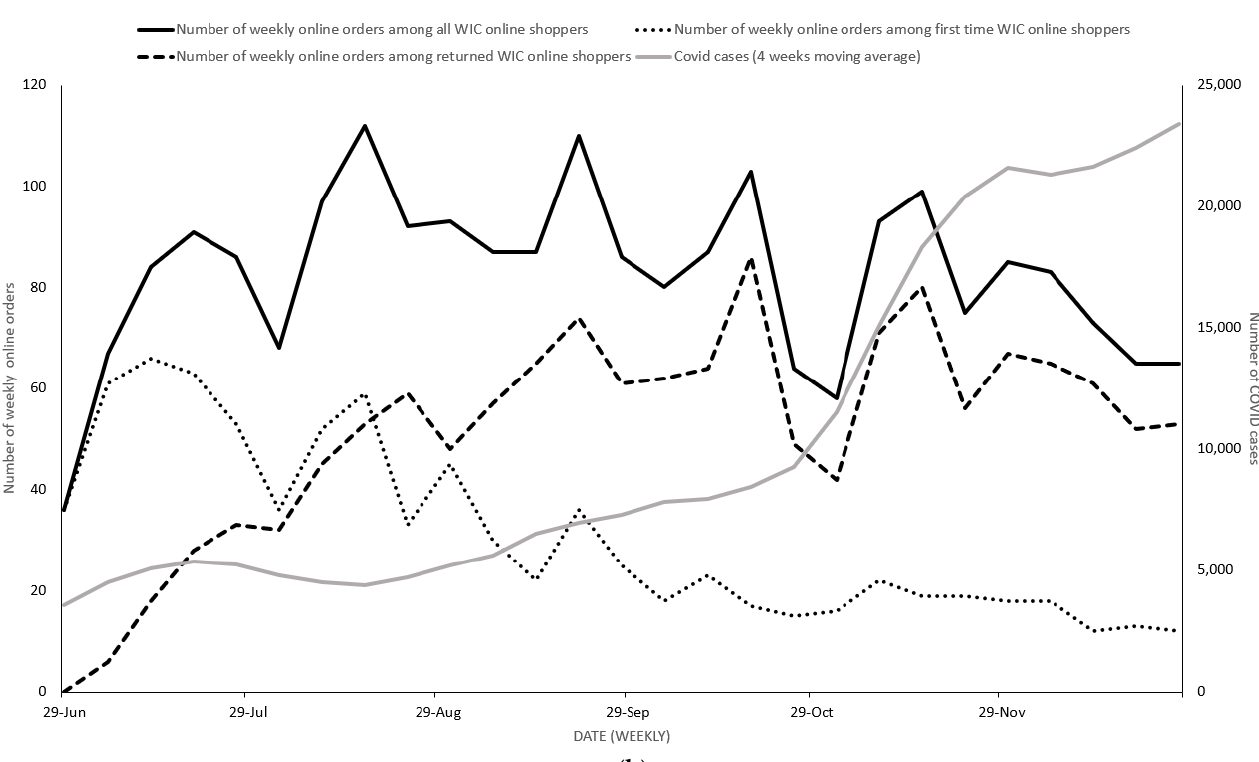
Figure 1. ( a ) The trends in the number of weekly WIC redemption visits in all stores and in the XYZ stores and the COVID-19 incidence. ( b ) The trends of weekly online orders and the weekly COVID-19 incidence.